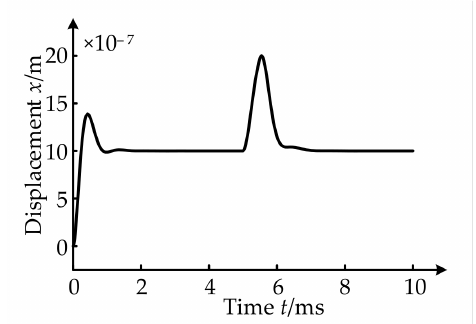
Figure 15. Output response curve of the rotor.